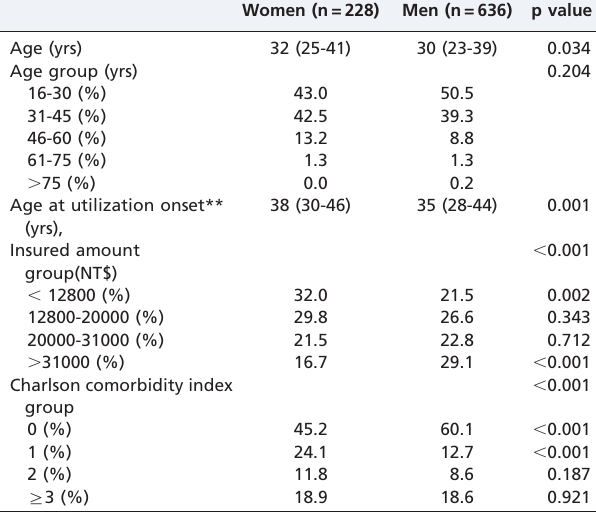
co-morbidity between men and women with ankylosing spondylitis